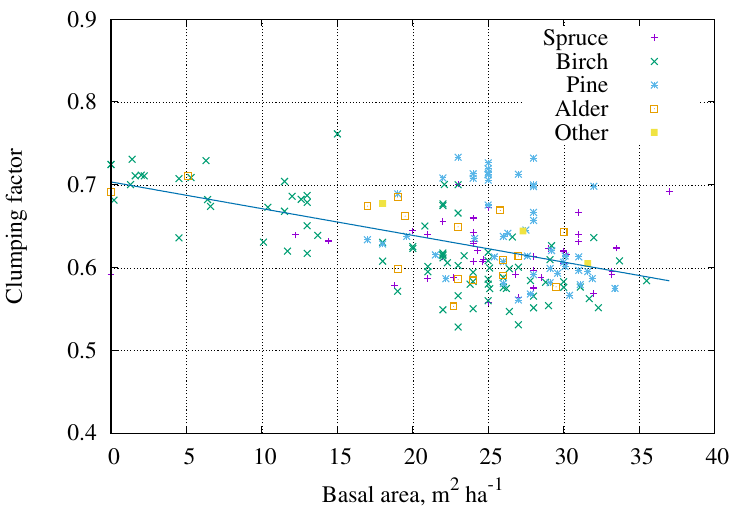
Figure 10. Basal area and clumping factor.